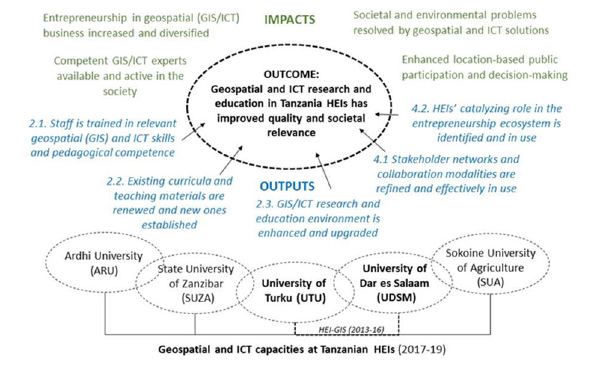
Figure 1. The overall structure and objectives (outputs) of the GEO-ICT project aim to improve the quality and societal relevance of geospatial-ICT research and